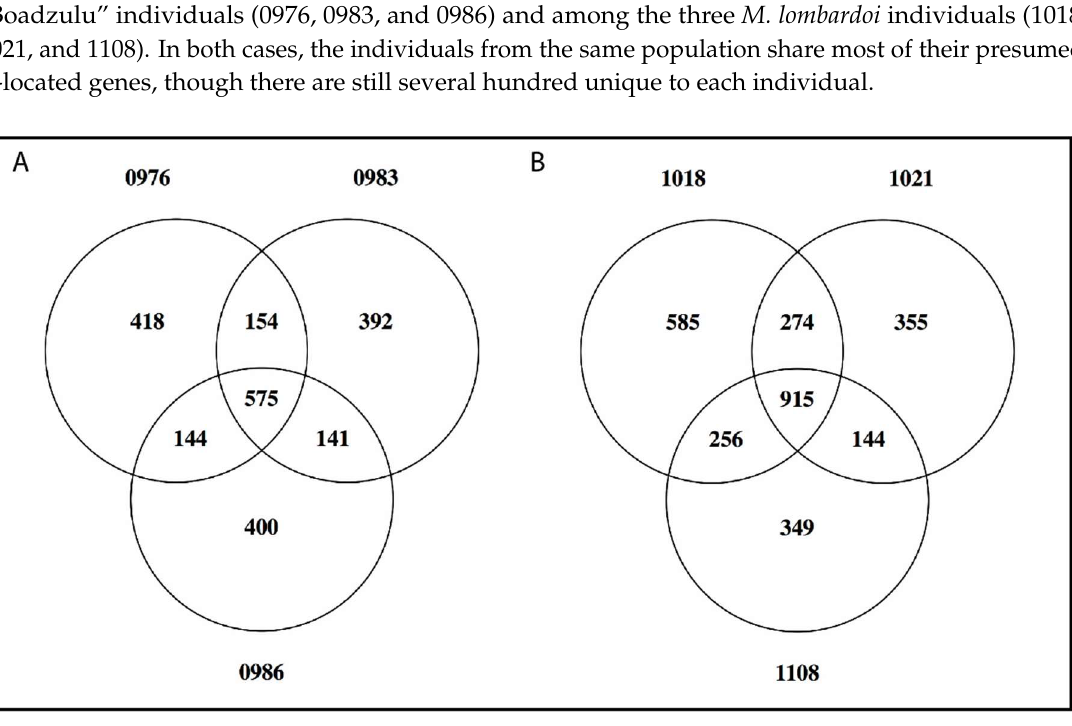
Figure 5. Shared B-located genes and gene fragments among individuals of the same population. The Venn diagrams show the number of genes and gene fragments shared by ( A ) three M. zebra “Nkhata Bay” individuals and ( B ) three M. lombardoi individuals.